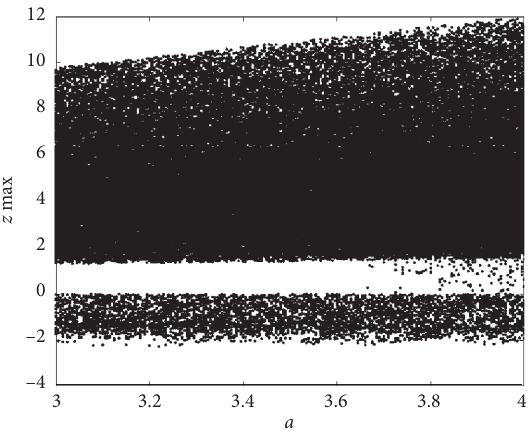
Figure 9: Bifurcation diagram according to the variation of parameter a .